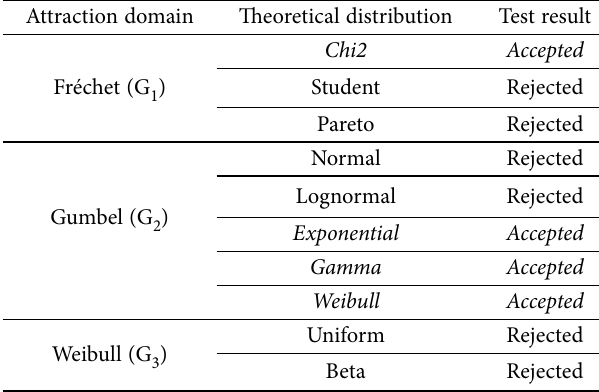
Table 2. Anderson-Darling test results Attraction domain